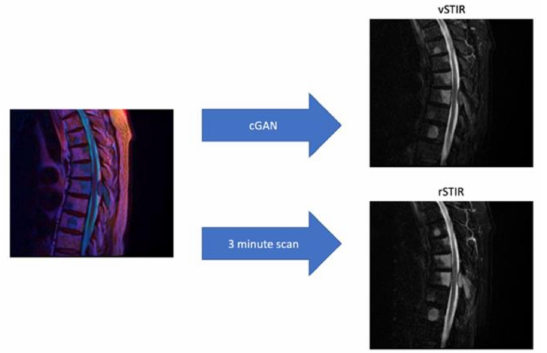
Figure 5. Acquisition of the virtual STIR image from the merged T1 and T2 image compared to the real STIR